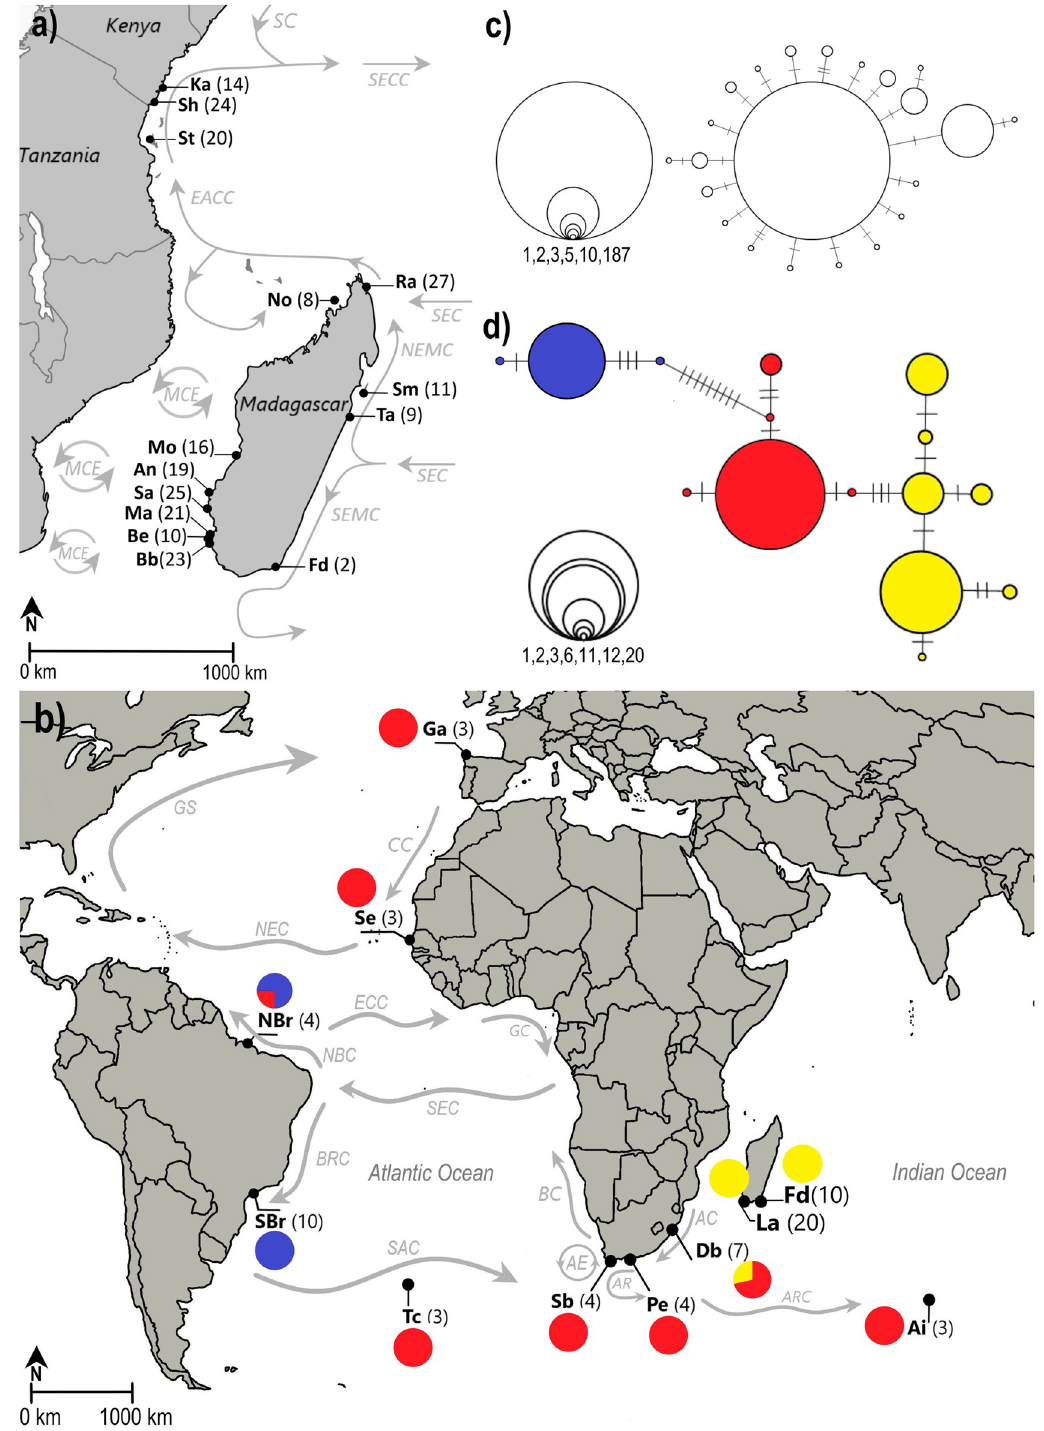
Fig 1. Maps showing sampling sites and haplotype networks for Octopus cyanea (a, c) and O . vulgaris (b, d). (a) Map of the Western Indian Ocean showing sampling sites for O . cyanea and prevailing currents during the Northeast Monsoon [32–34]. (b) Map of the Atlantic and Indian Ocean showing sampling sites for O . vulgaris and major currents [35,36].Pie charts show the fractional contribution of the defined haplogroups in the haplotype network (see d) for each of the sample sites.